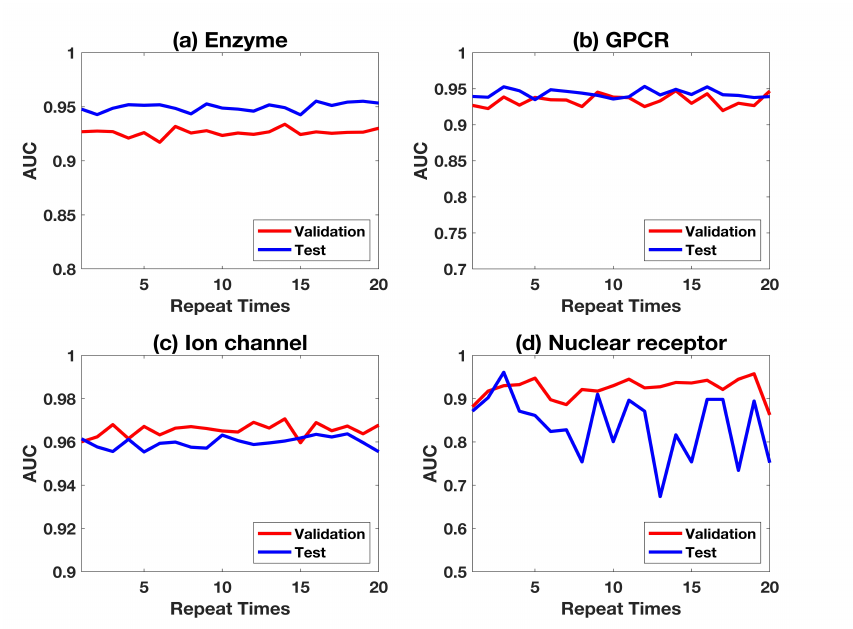
Figure 4. Fluctuations of AUCs in four